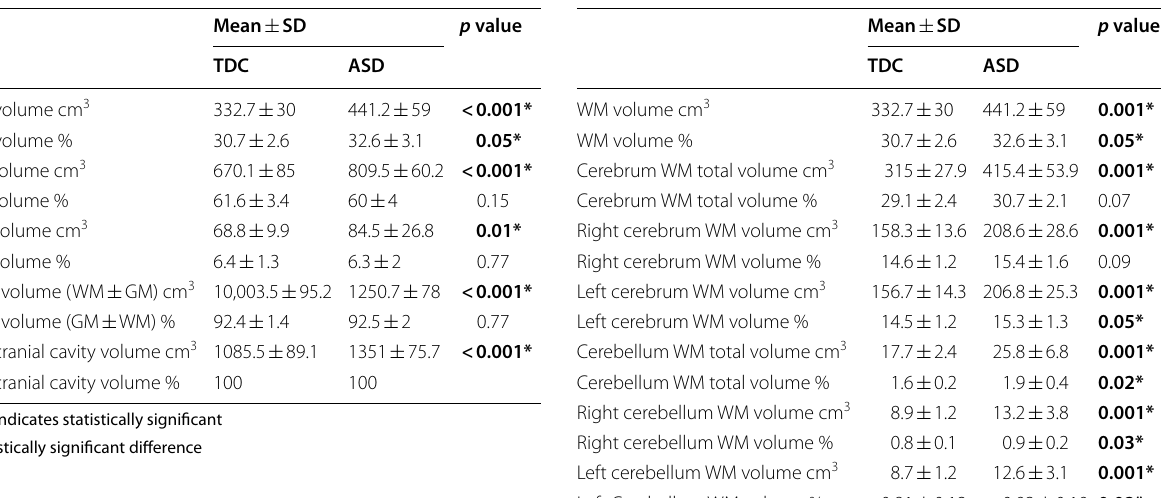
Table 2 Comparing total brain, intracranial cavity, white matter, grey matter, and CSF mean volumes in TDC and ASD groups